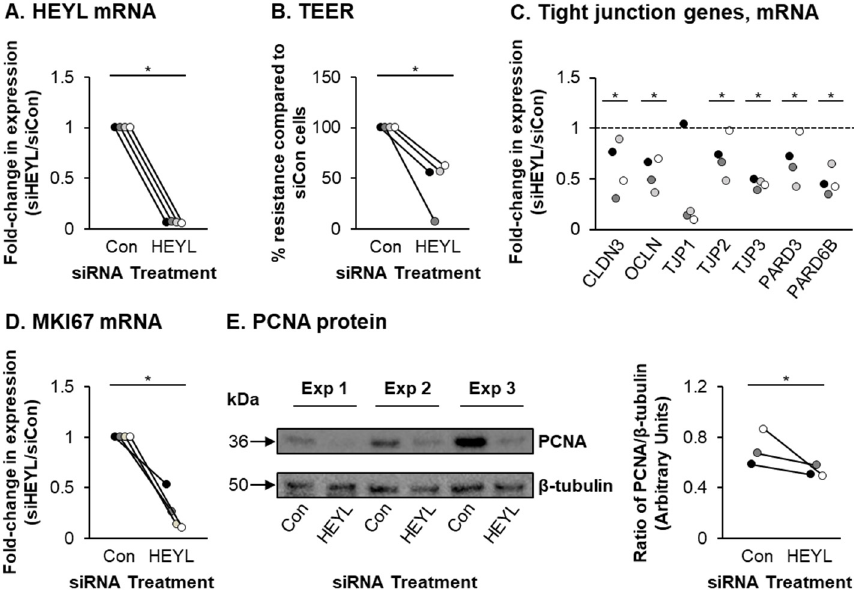
Figure 4. siRNA-mediated knockdown of HEYL suppresses proliferation. HBECs ( n = 4 normal, nonsmoker donors) were transfected with either control (siCon) or HEYL (siHEYL) specific siRNA during seeding on ALI culture. On ALI day 7 the cells were harvested for analysis. ( A ) qPCR analysis of HEYL. For each donor, the data are presented as fold-change in expression compared to siCon cells. ( B ) Transepithelial electrical resistance (TEER). For each donor, the resistance (ohms) is plotted as percentage (%) resistance compared to siCon cells. ( C ) qPCR analysis of the tight junction-related genes CLDN3, OCLN, TJP1, TJP2, TJP3, PARD3 and PARD6B. For each donor, the data are presented as fold-change in expression compared to siCon cells. ( D ) qPCR analysis of MKI67 expression. For each donor, the data are presented as fold-change in expression compared to siCon cells. ( E ) Western blot analysis of PCNA protein levels. β -tubulin was used as loading control. Data presented as ratio of PCNA/ β -tubulin protein levels between siCon and siHEYL treated cells from n = 3 normal, nonsmoker donors. * p < 0.05.